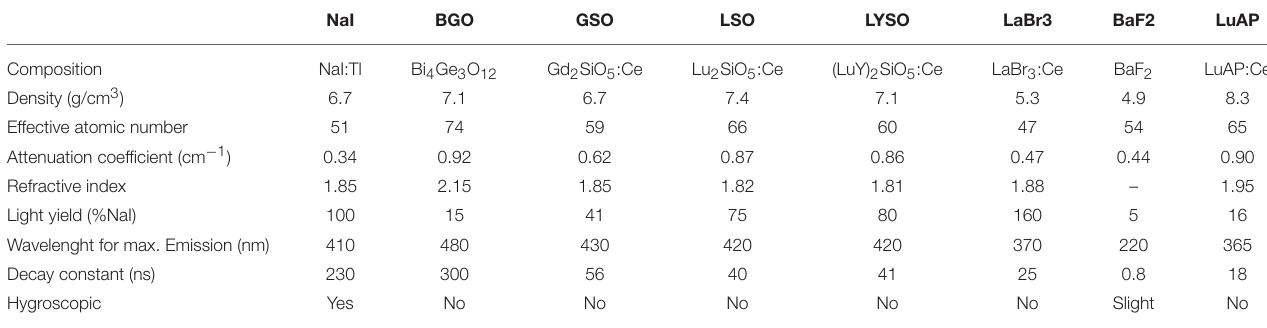
TABLE 3 | Physical properties of some scintillators used in medical imaging applications (adapted from Lewellen [77]). NaI BGO GSO